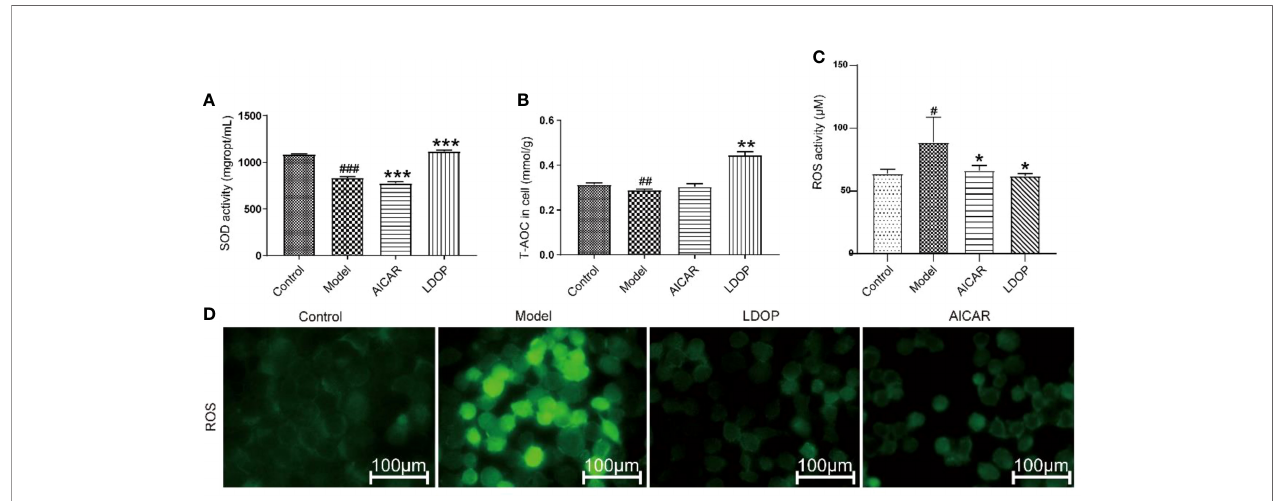
FIGURE 8 | Effects of LDOP-1 on the production of SOD, T-AOC and ROS. (A – C) The levels of SOD, T-AOC and ROS were measured using a biochemical markers kit. The expression of ROS was detected by Immuno fl uorescence technique (D) . Data are expressed as the mean±SD of three independent experiments.